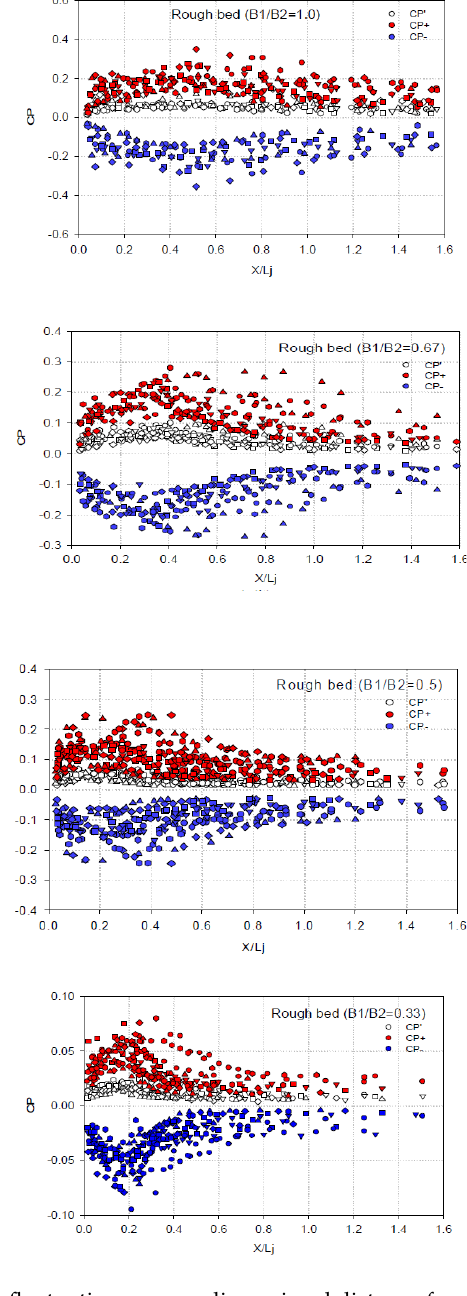
Figure 10. Positive and negative pressure fluctuations versus dimensional distance from jump toe and range of the Froude numbers.